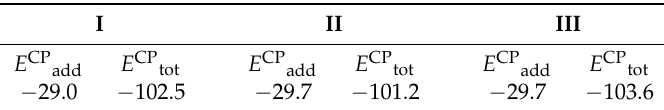
Table 1. Interaction energies ( E CP add and E CP tot ) for clusters I – III at PBE0-D3/BS3// PBE0/BS1 level (kcal/mol).